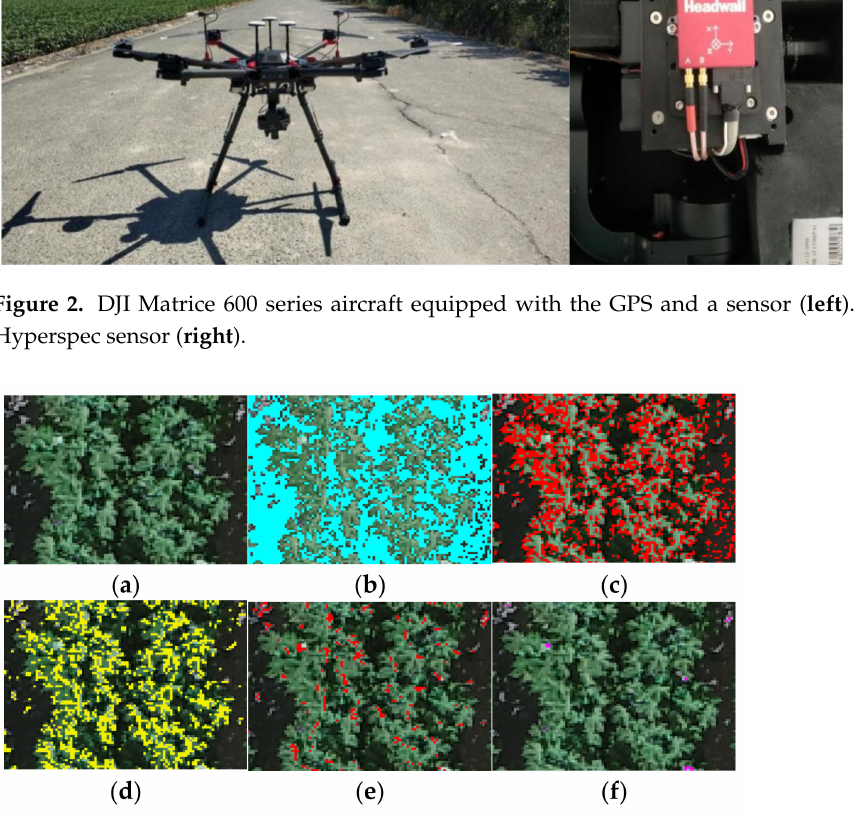
Figure 3. Image extraction range. ( a ) is a part of the image intercepted from the canopy RGB image, ( b ) refers to irrelevant substances such as soil and plastic film, ( c – f ) refers to various leaf postures of the photographed cotton canopy. It should be noted that there are only 5 categories here, and 49 categories will be used to show the posture of cotton leaves in more detail in this